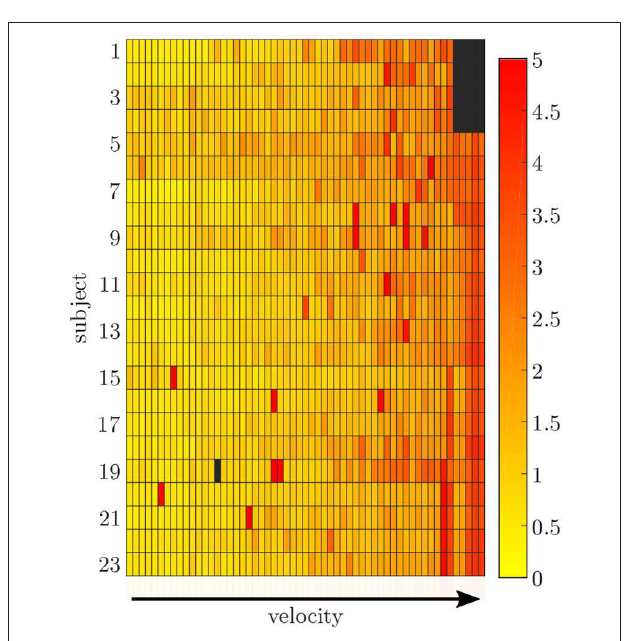
FIGURE 6 | Root-mean-squared error between the measured and simulated data exemplarily displayed for the pelvis sensor. With an increasing gait velocity the simulation error increases. Some trials show outliers with larger errors during slow